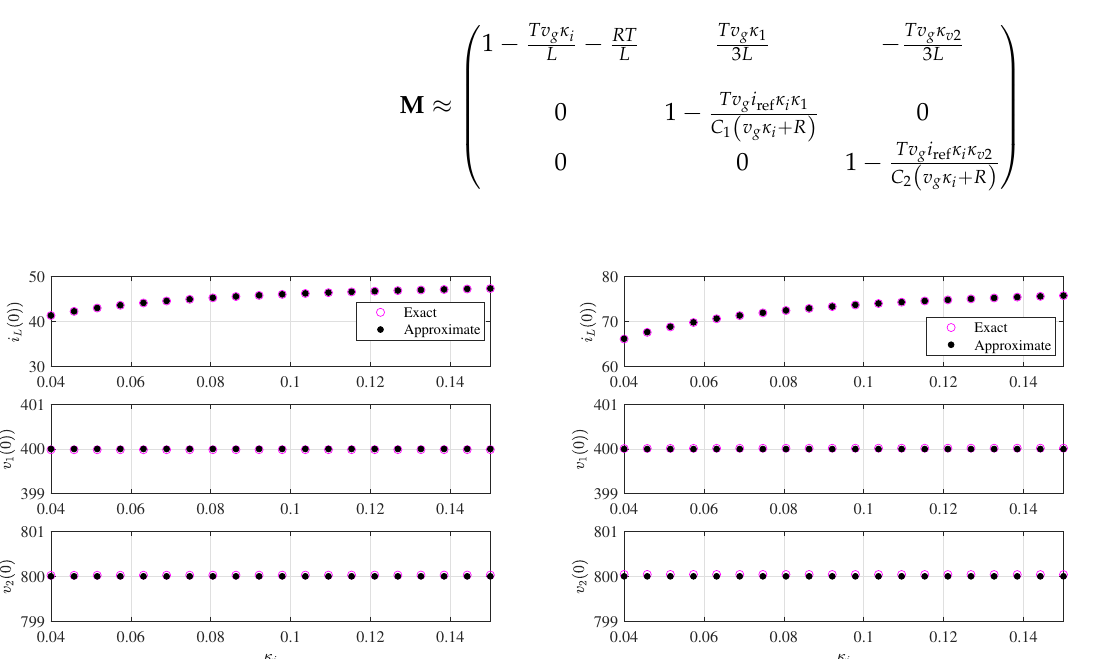
Figure 8. Evolution of the coordinates of the vector x ( 0 ) according to the exact expression (9) and its approximate (39) with respect to the feedback gain κ i for ( Left ): i ref = 50 A and ( Right ): i ref = 80